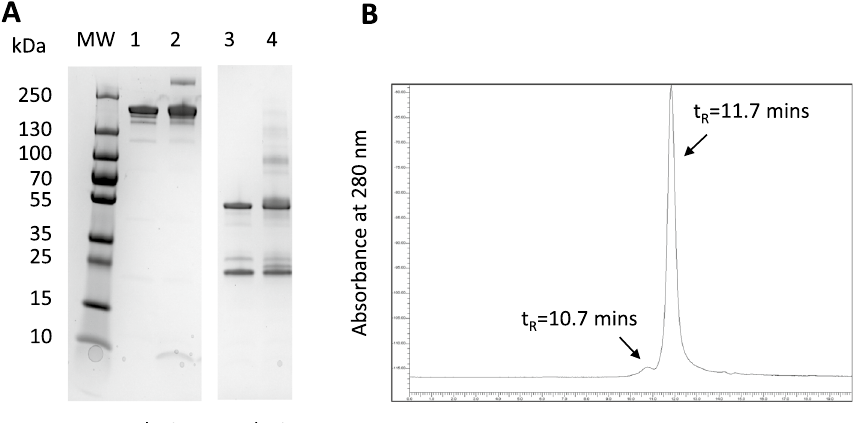
Fig. 5 A SDS-PAGE analysis on a 4–20% Tris HCl gradient mini-gel of trastuzumab or BnDTPA-trastuzumab-NLS from kit lot 17N014 after storage at 2–8 °C for 661 d, under non-reducing conditions (lanes 1 and 2, respectively) or reducing (DTT) conditions (lanes 3 and 4 respectively). MW: broad range molecular weight standards. The gel was stained with Coomassie R-250 Brilliant Blue. B SE-HPLC analysis of BnDTPA-trastuzumab-NLS from kit lot 17N014 after storage at 2–8 °C for 661 d on a BioSep SEC-s4000 column (Phenomenex, Torrance, CA, USA) eluted with 100 mM NaH 2 PO 4 buffer, pH 7.0 at a flow rate of 0.8 mL/min with UV detection at 280 nm. BnDTPA-trastuzumab-NLS exhibited one major peak with retention time (t R 11.7 min) and a second peak at t R 10.7 min = =